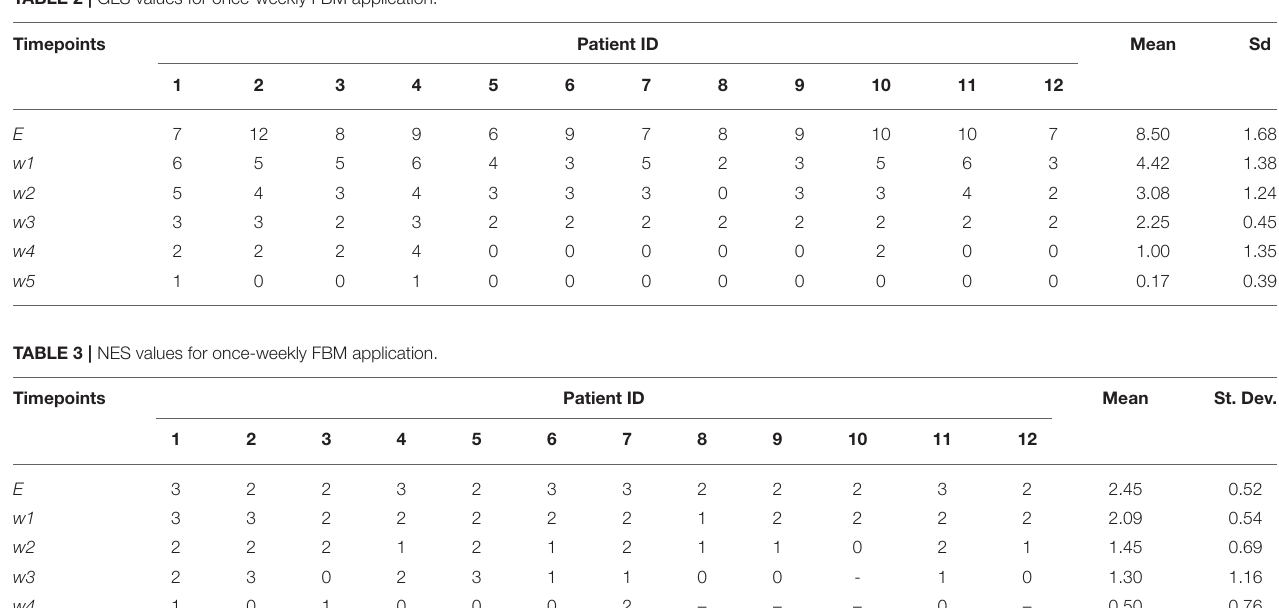
TABLE 2 | GLS values for once-weekly FBM application.